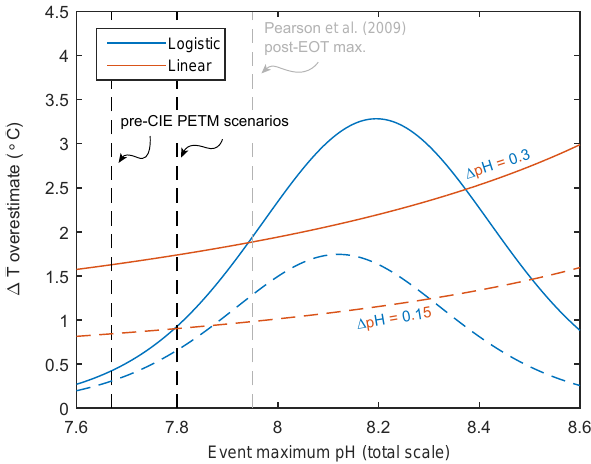
Figure 4. Temperature overestimate across climatic events if it is assumed that pH change exerts no control on foraminifera Mg / Ca. Overestimates derived from both a logistic and linear relationship between Mg / Ca and pH are shown for a 0.3 unit pH shift (solid lines) and a 0.15 unit pH shift (dashed lines). pH scenarios for both the PETM (Panchuk et al., 2008; Zeebe et al., 2009) and the EOT (Pearson et al., 2009) are